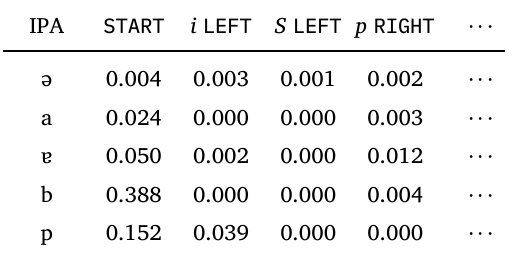
Example of feature matrix for embedding encoding: every phoneme is represented by an array of floating point values, which correspond to the probabilities that other phonemes occur before or after this phoneme. The values in a row sum to